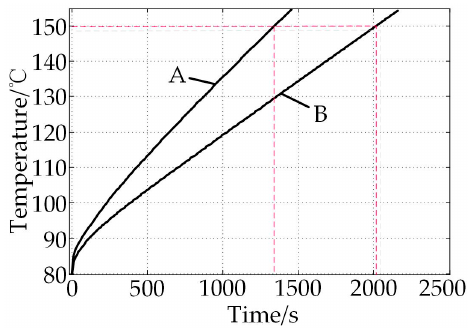
Figure 17. The temperature rise curves of the maximum-temperature node.